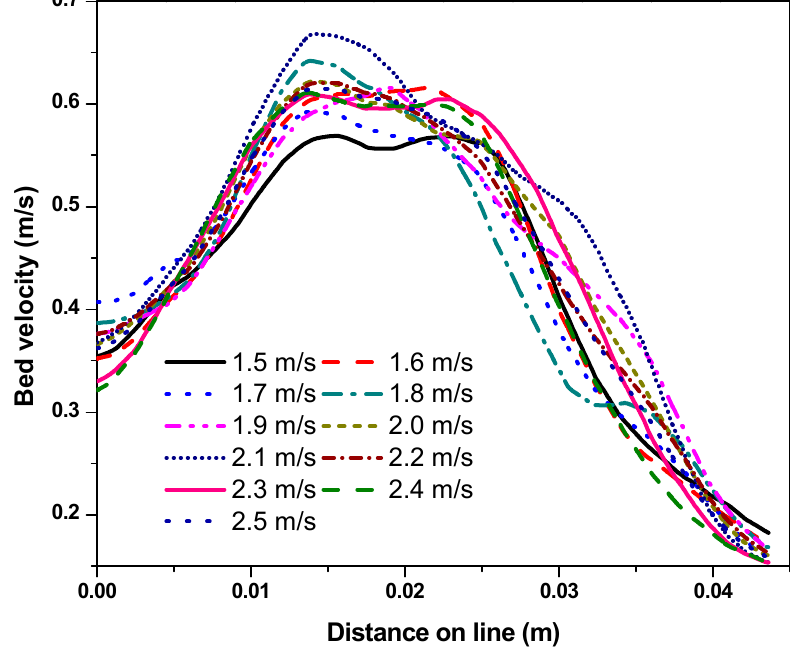
Figure 5. Bed velocity versus distance on line for a 500 g bed weight, a 30° blade inclination angle, and different superficial air velocities.